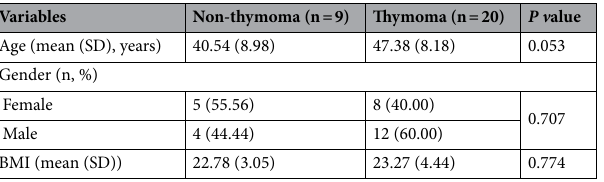
Table 1. Baseline characteristics of patients included in the study. SD standard